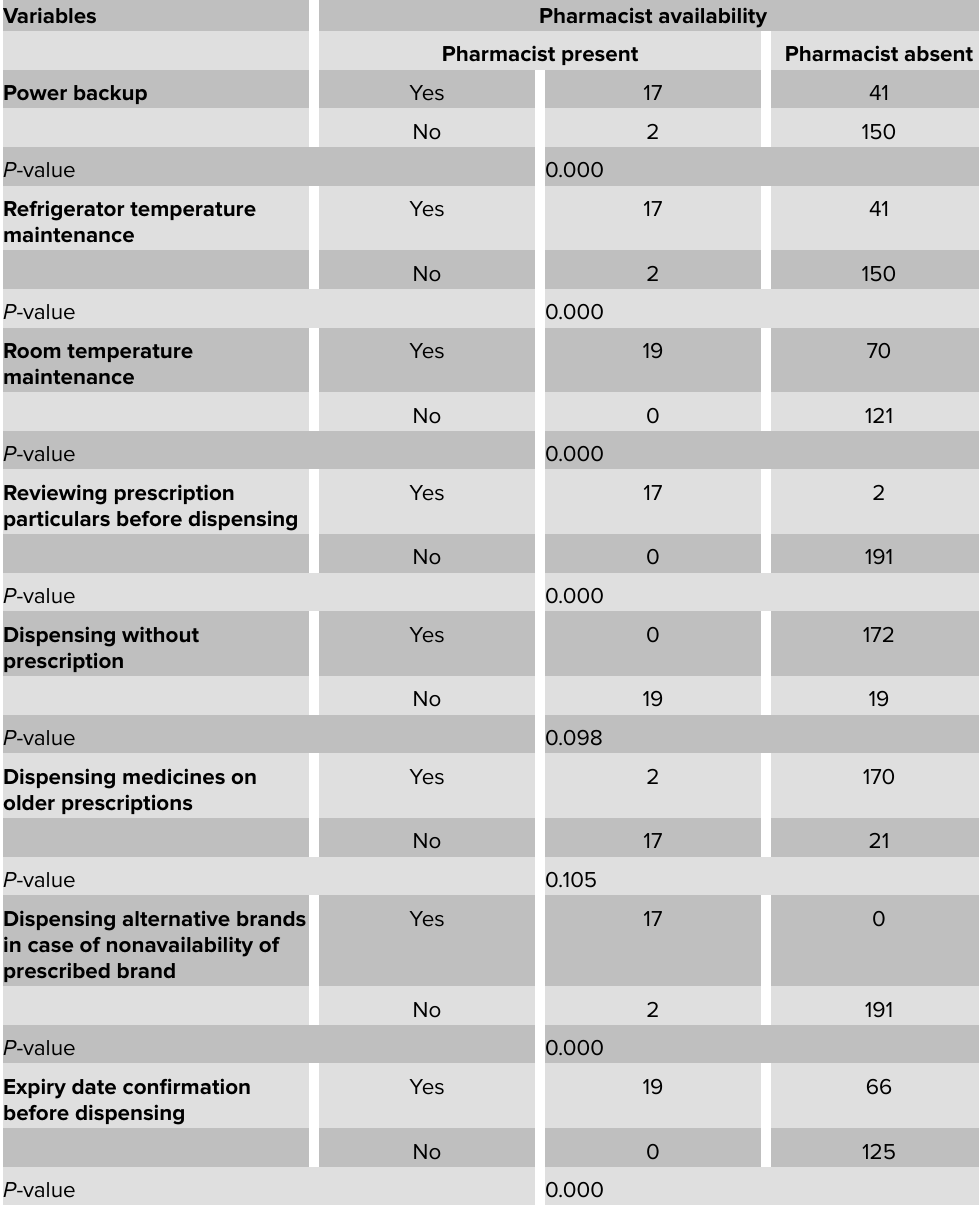
TABLE 5: Cross-tabulation of